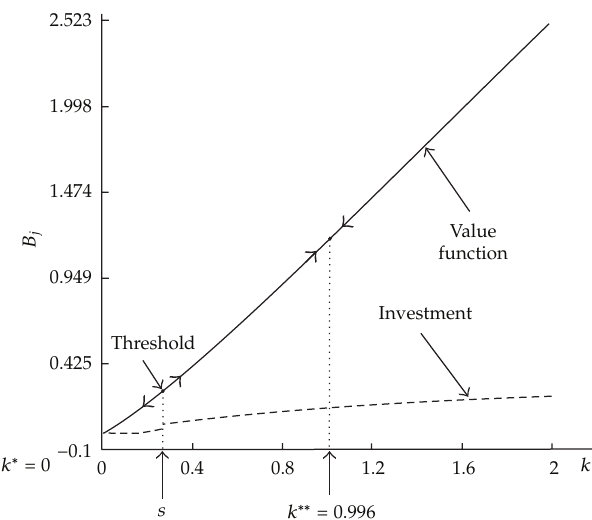
Figure 2: Optimal value function and optimal